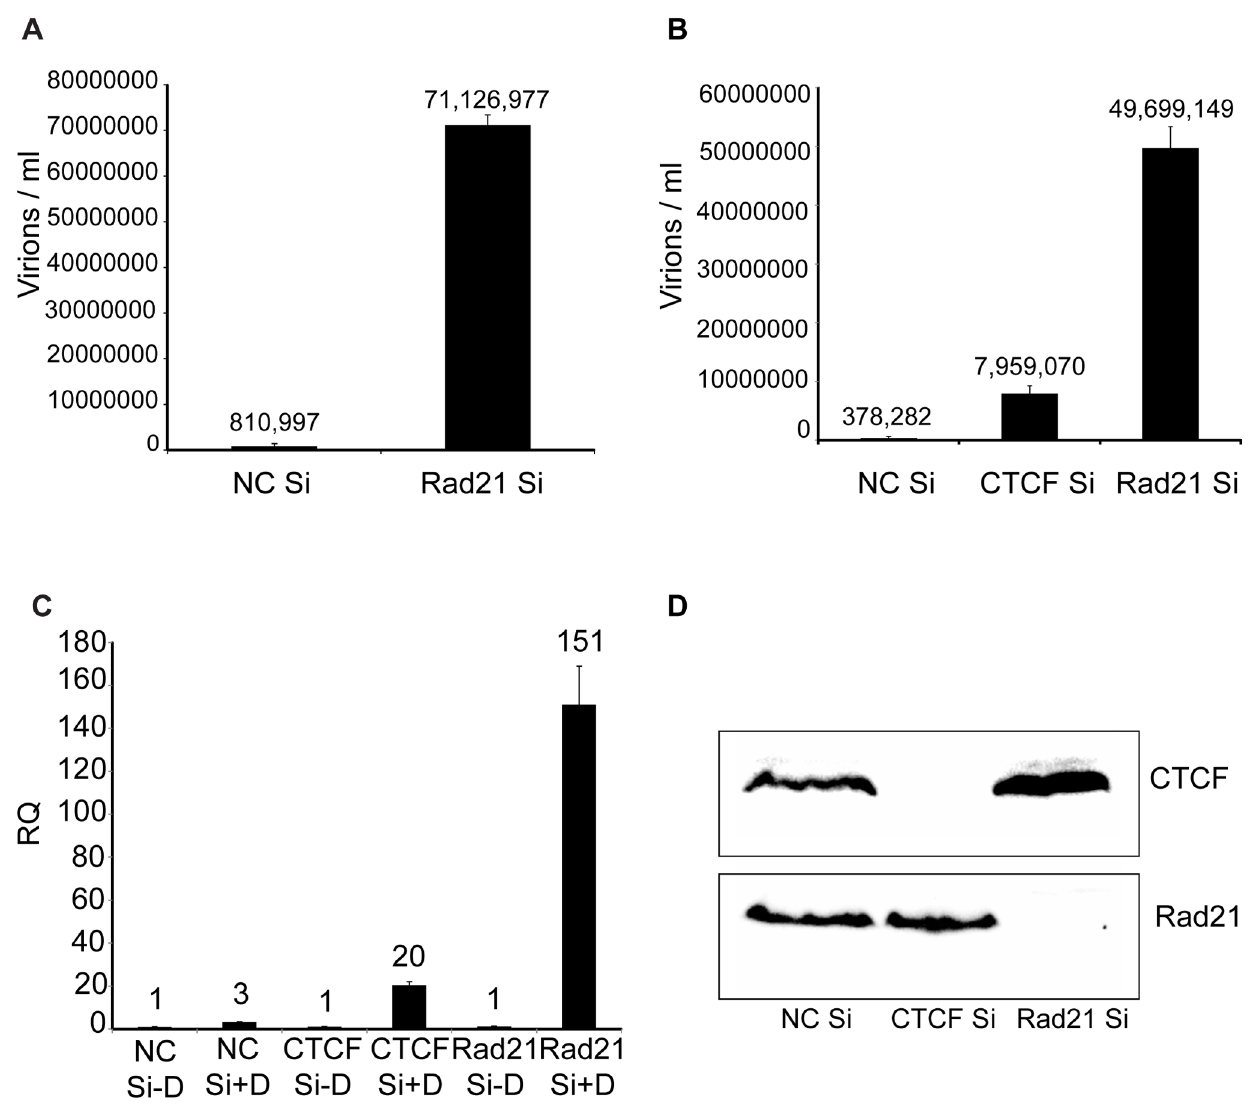
Figure 4. KSHV virus production in cells depleted of Rad21. A. KSHV-infected iSLK cells were transfected with either control siRNA (NC Si) or Rad21-specific siRNA (Rad21 Si), and KSHV replication was induced by treatment with doxycycline. Supernatants from induced cells were used to infect 293 cells. Virus passage was quantitated by flow cytometry of GFP-positive 293 cells. Each transfection/induction was performed in triplicate and three replicate infections were performed with each supernatant. B. CTCF knockdown (CTCF Si) and Rad21 knockdown (Rad21 Si) were performed on iSLK cells in parallel with control siRNA transfection (NC Si). Lytic replication was induced and virus production was measured by passage of virus to KSHV-negative 293 cells as in (A) above. C. CTCF, Rad21 and negative control knockdown were performed in iSLK cells as in (B) above and DNA was isolated from cell pellets. KSHV genome copy number was measured by qPCR. Cells were either untreated ( 2 D) or treated with doxycycline ( + D) to induce replication. RQ (relative quantitation). D. Immunoblotting of lysates from cells used in virus production experiments in panel B above was performed with anti-CTCF and anti-Rad21 antibodies to verify completeness of CTCF and Rad21 depletion. Lysates were prepared from cells harvested at the time of replication induction with